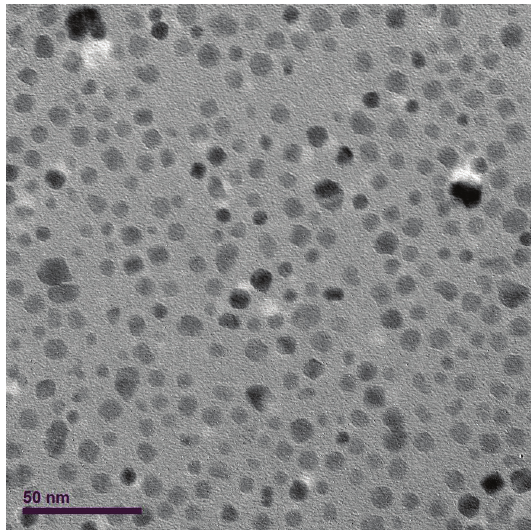
Figure 4. Representative TEM micrograph of the titanium nitride phase (shown in dark-grey/black